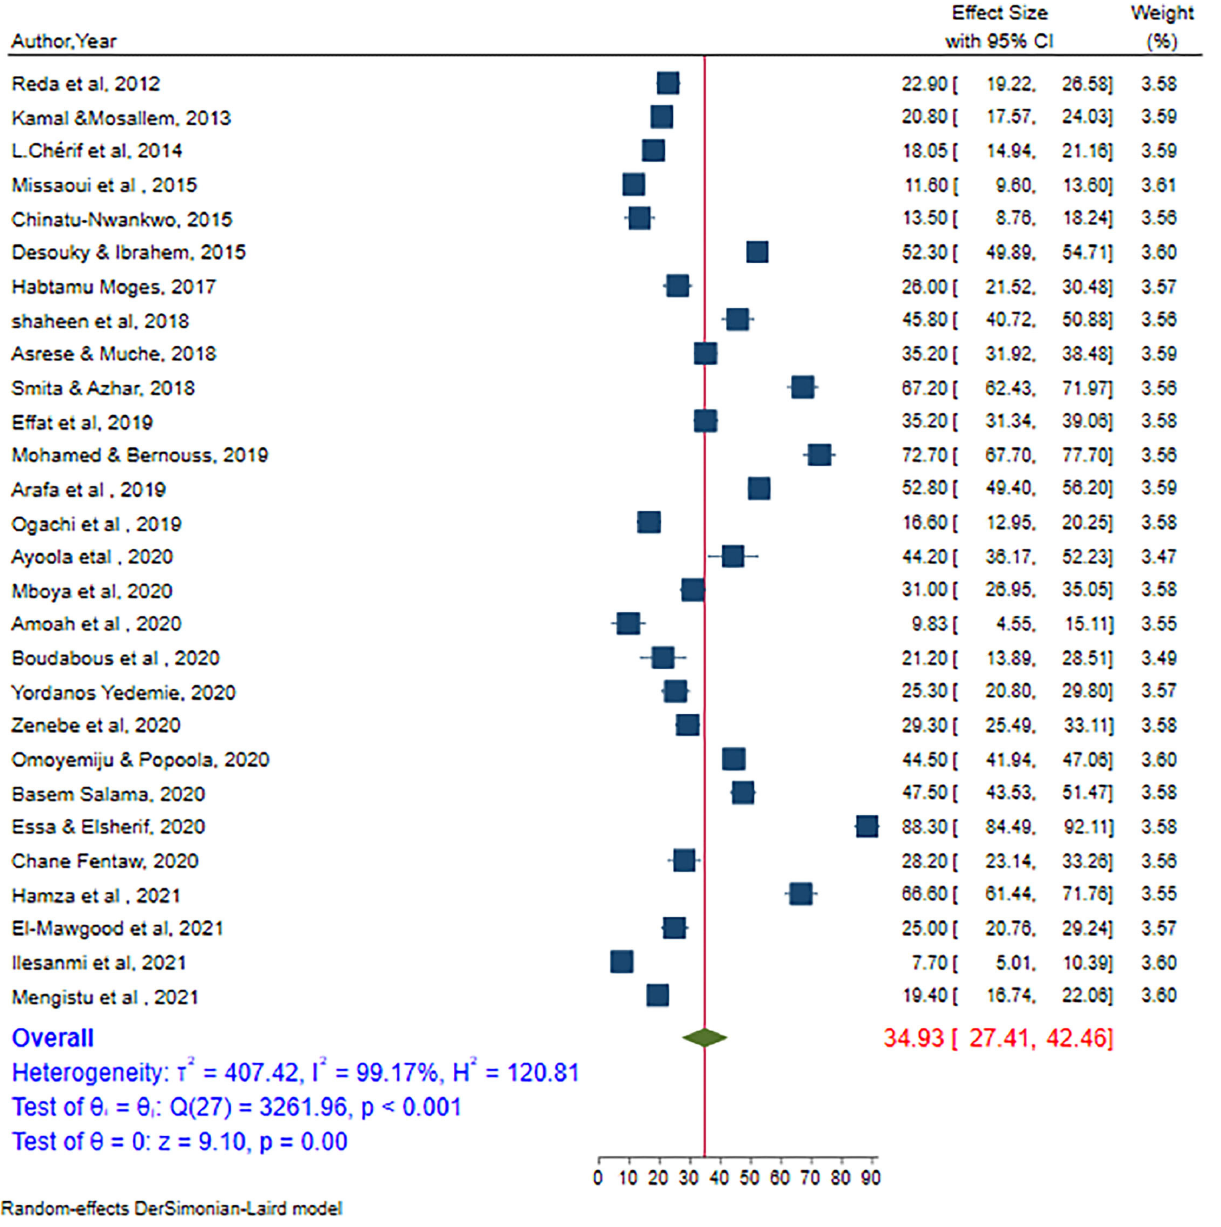
Frontiers in Psychology |